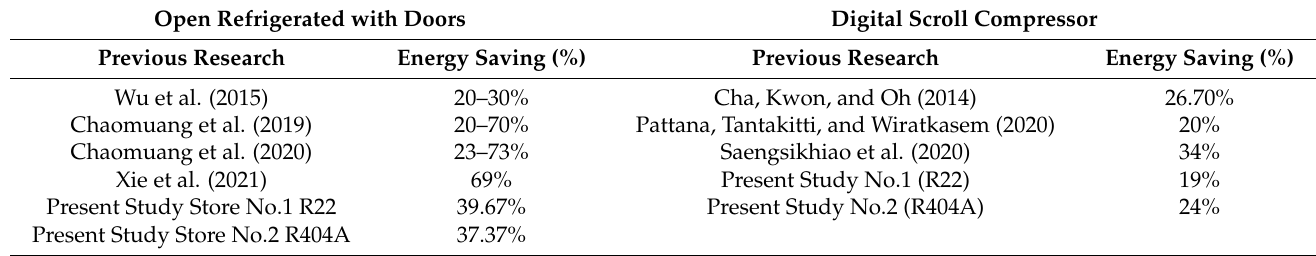
Figure 12. The operating status for the digital semi-hermetic compressor. Table 1. The energy savings compared with previous